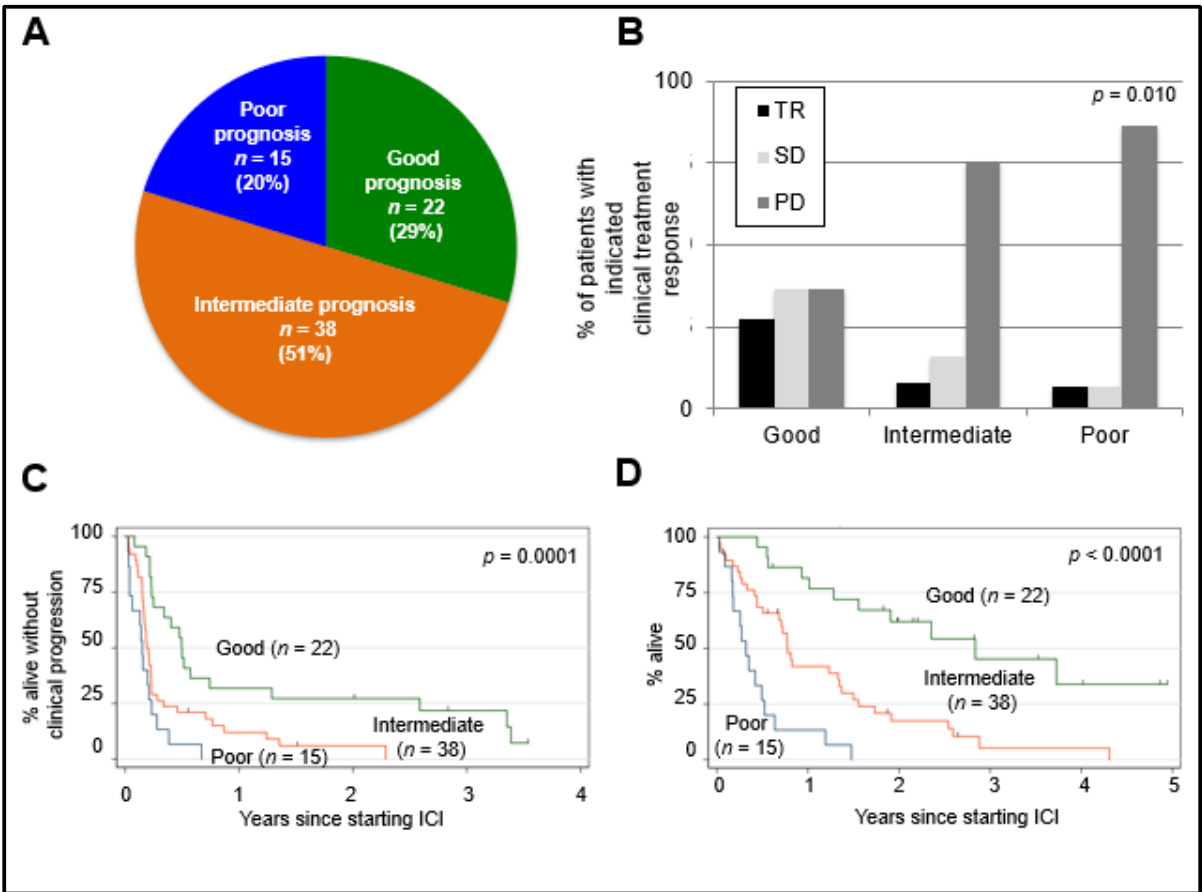
Figure 3. Association between Metastatic Uveal Melanoma Prognostic Score (MUMPS) groups and clinical outcomes. Patients were categorized based on the number of MUMPS good prognosis factors they possessed. Good prognosis factors were absence of bone metastases, >2 years from initial diagnosis to metastatic disease, LDH < 1.5 × ULN. ( A ) The percentage of patients classified as having good prognosis (MUMPS = 3), intermediate prognosis (MUMPS = 2), and poor prognosis (MUMPS = 0–1) are indicated. ( B ) Distribution of clinical treatment responses according to MUMPS groups are indicated; p = 0.010; Fisher’s exact test. ( C ) cPFS according to MUMPS groups. ( D ) OS according to MUMPS groups. Log-rank test p = 0.0001 (cPFS); p < 0.0001 (OS). Tick marks indicate censored patients. Good prognosis ( n = 22) = green line, Intermediate prognosis ( n = 38) = orange line, Poor prognosis ( n = 15) = blue line. TR = tumor response, SD = stable disease, PD = progressive disease.